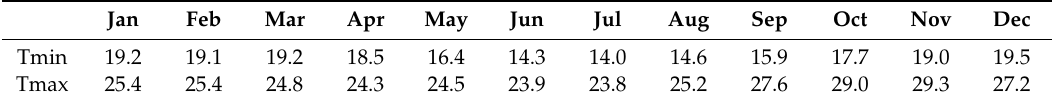
Figure 6. Exceedance probabilities for the seven utilized CORDEX Africa datagrids after bias-correction. Each graph shows the ranked precipitation for all six RCMs, their ensemble mean, and the observed precipitation at the corresponding datagrid (1951–2005). Missing values were neglected in this visualization. The lines representing the exceedance probabilities for the observed precipitation, as well as for models 1 to 5, are superimposed by the distribution of model 6 due to their similar exceedance probabilities after bias correction. Table 3. Historical monthly average minimum (Tmin) and maximum temperature (Tmax) according to the bias-corrected RCM simulations (1979–2005). The given values represent the average of the monthly average Tmin and Tmax of all 21 utilized CORDEX Africa grids,